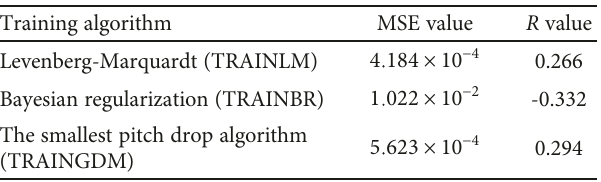
Table 12: Values of MSE and R depending on the training algorithms (for two neurons in the hidden layer) in model ANN 4.